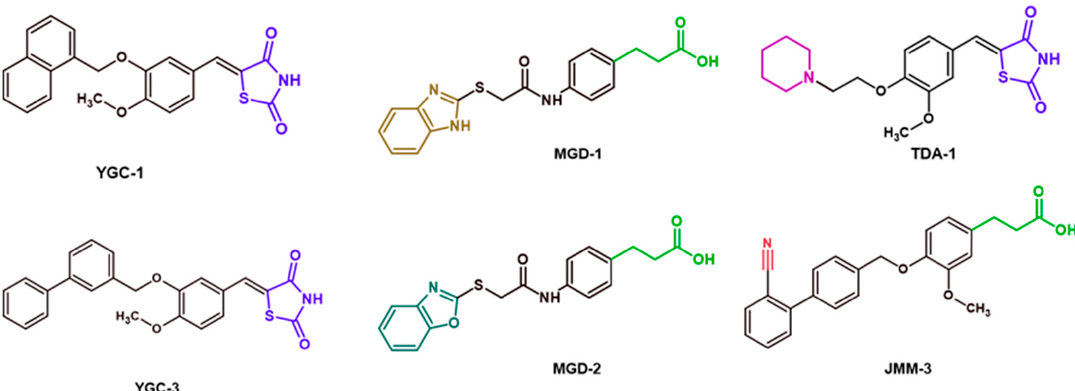
Molecules 2021 , 26 , x FOR PEER REVIEW Figure 4. Structure generated of the G6PD protein from Helicobacter pylori : ( A ) structural alignment of HpG6PD (light blue color) with the G6PD of L. mesenteriodes (orange color); ( B ) surface representation of HpG6PD, the Rossmann domain is colored green and essential residues are shown as stick models—the coenzyme NADP + and the substrate G6P binding sites are shown in red; ( C ) close-up of the probable binding site of both the NADP + and G6P substrates; and ( D ) close-up of the substrate and coenzyme interactions with keys amino acids, NADP + (cyan color), 6PG (yellow color).